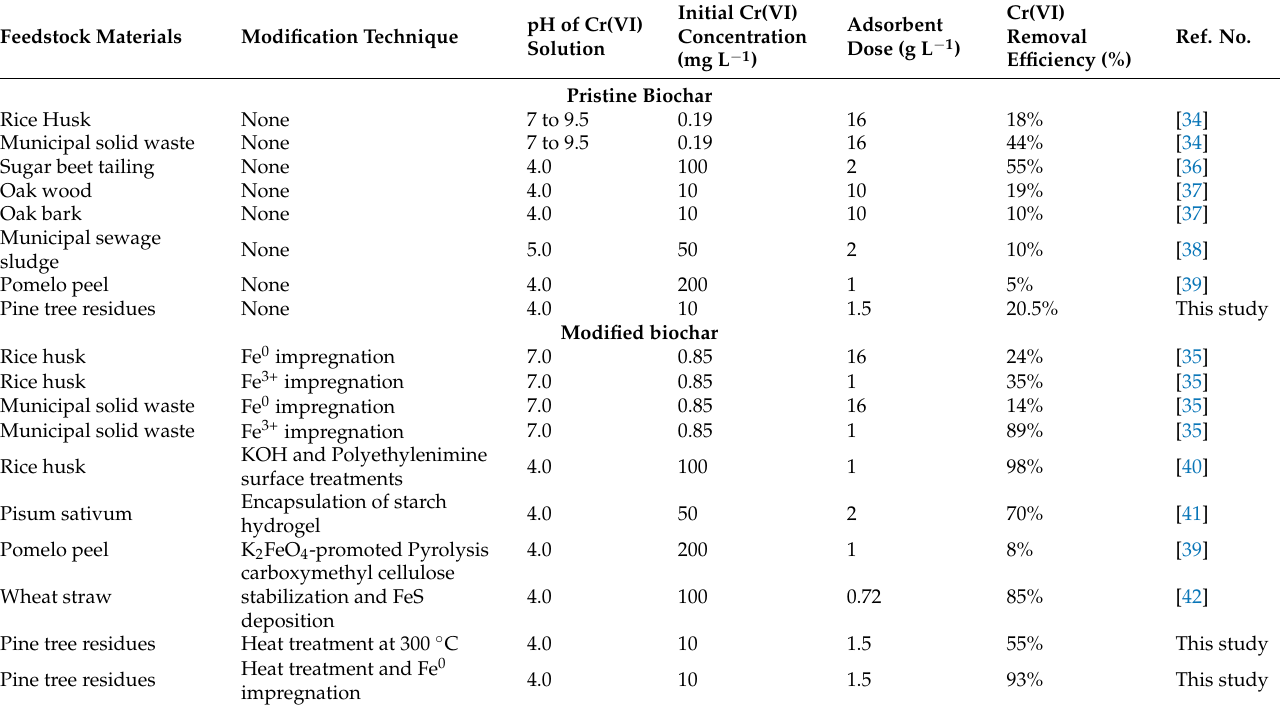
Table 2. Summary of previous studies on the application of biochar for aqueous Cr(VI) removal.